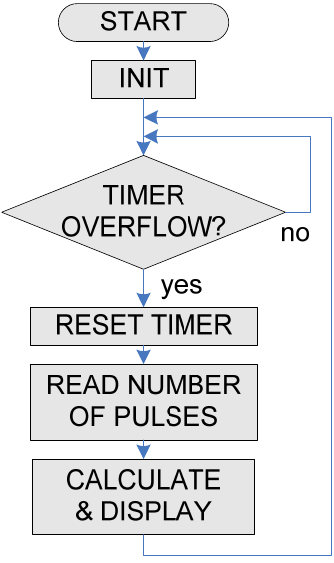
Figure 8. Program flow